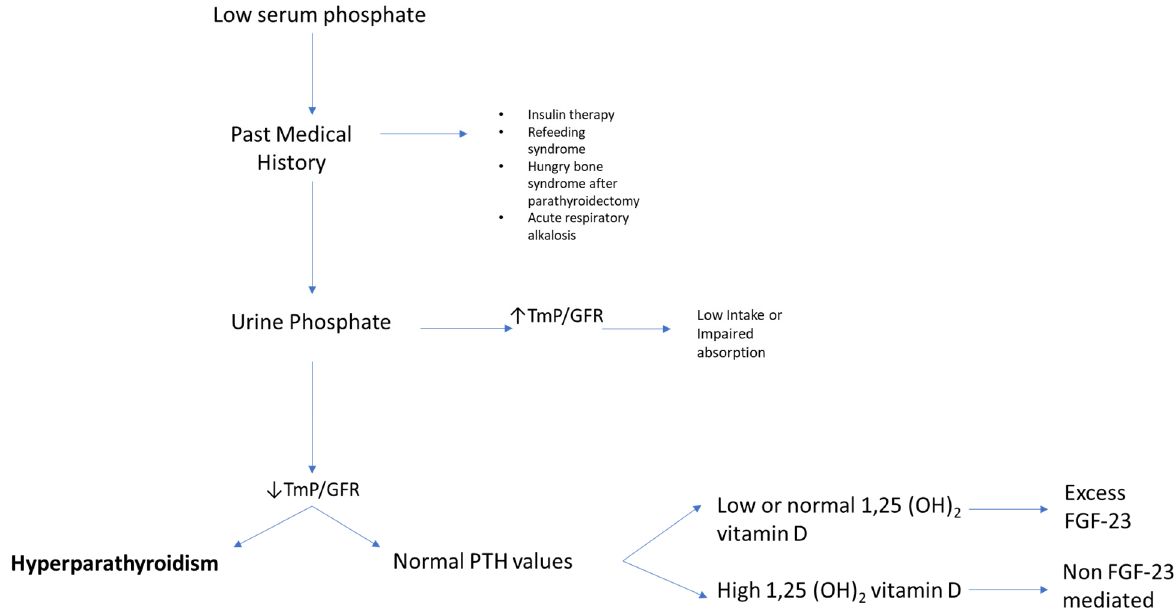
Figure 2. Flowchart for evaluating patients presenting with low serum phosphate (hypophosphatemia). High TmP/GFR is indicative of high renal reabsorption of phosphate, which is appropriate in case of low intake or malabsorption. When TmP/GFR is inappropriately low in the setting of hypophosphatemia, this suggests renal phosphate wasting. Legend: TmP/GFR, maximum tubular reabsorption of phosphate corrected for glomerular filtration rate.